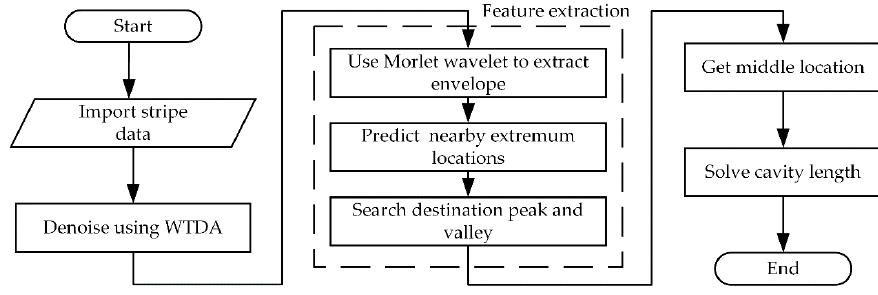
Figure 1. Fabry–Perot (F ‐ P) cavity demodulation flowchart.